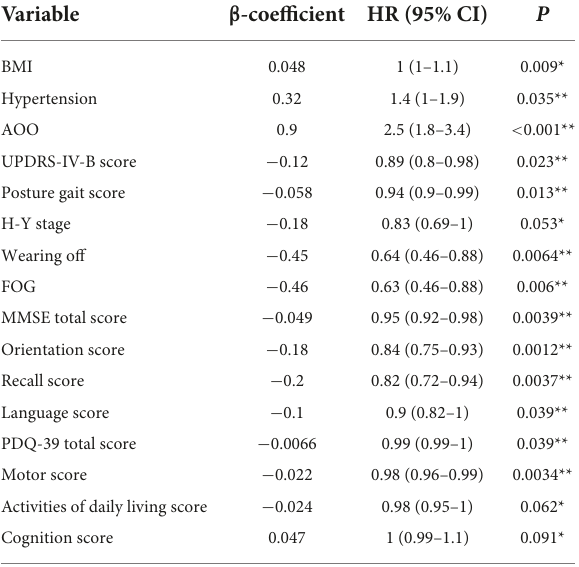
TABLE 4 Univariate Cox proportional risk regression